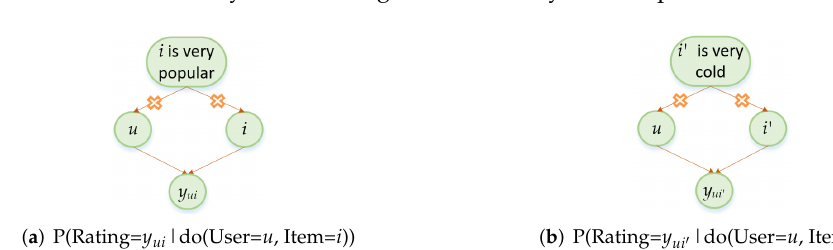
Figure 3. Using the do () operator to block the path directed to u , i , or i (cid:48) to identify and eliminate the influences of confounding